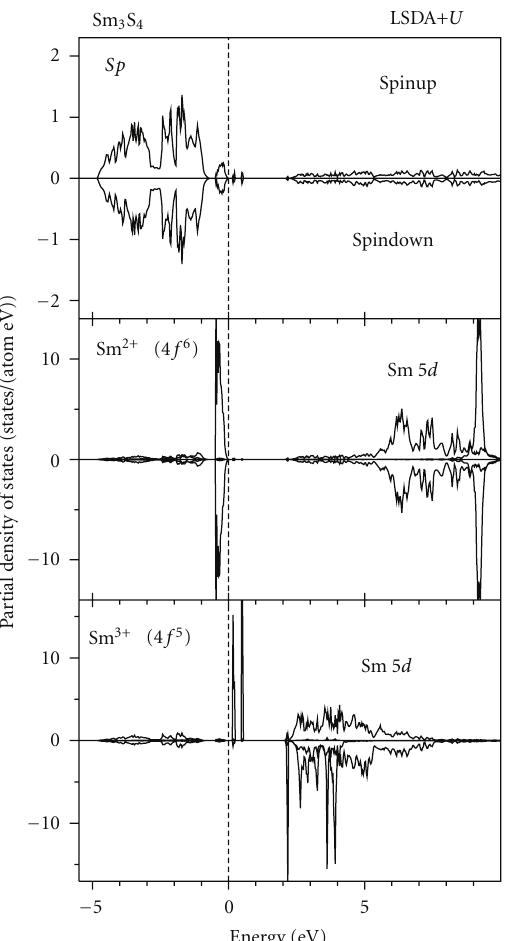
Figure 88: The partial density of states (DOS) (in states/(atom eV)) of Sm 3 S 4 calculated in LSDA+ U approximation [455].